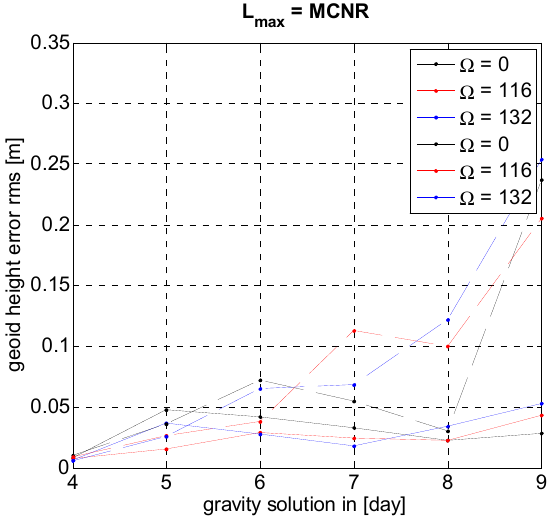
Figure 11. Global error RMS in terms of geoid height for odd (solid line) and even (dashed line) parities (inline scenarios a and b of the Table 2, respectively) for the gravity solutions up to maximum spherical harmonic degree and order MCNR. Different colors stand for different Ω .